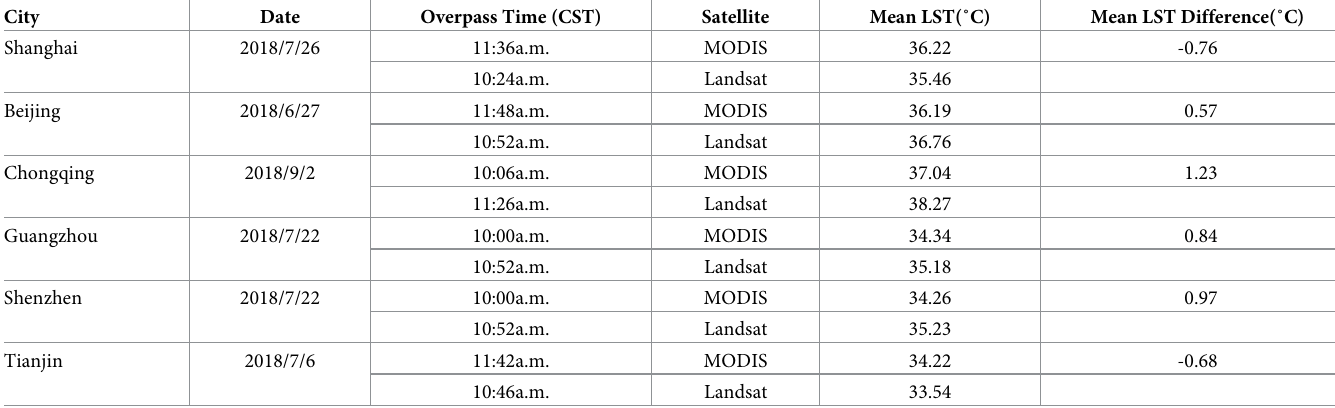
Table 3. Results comparison of retrieve accuracy of LST.